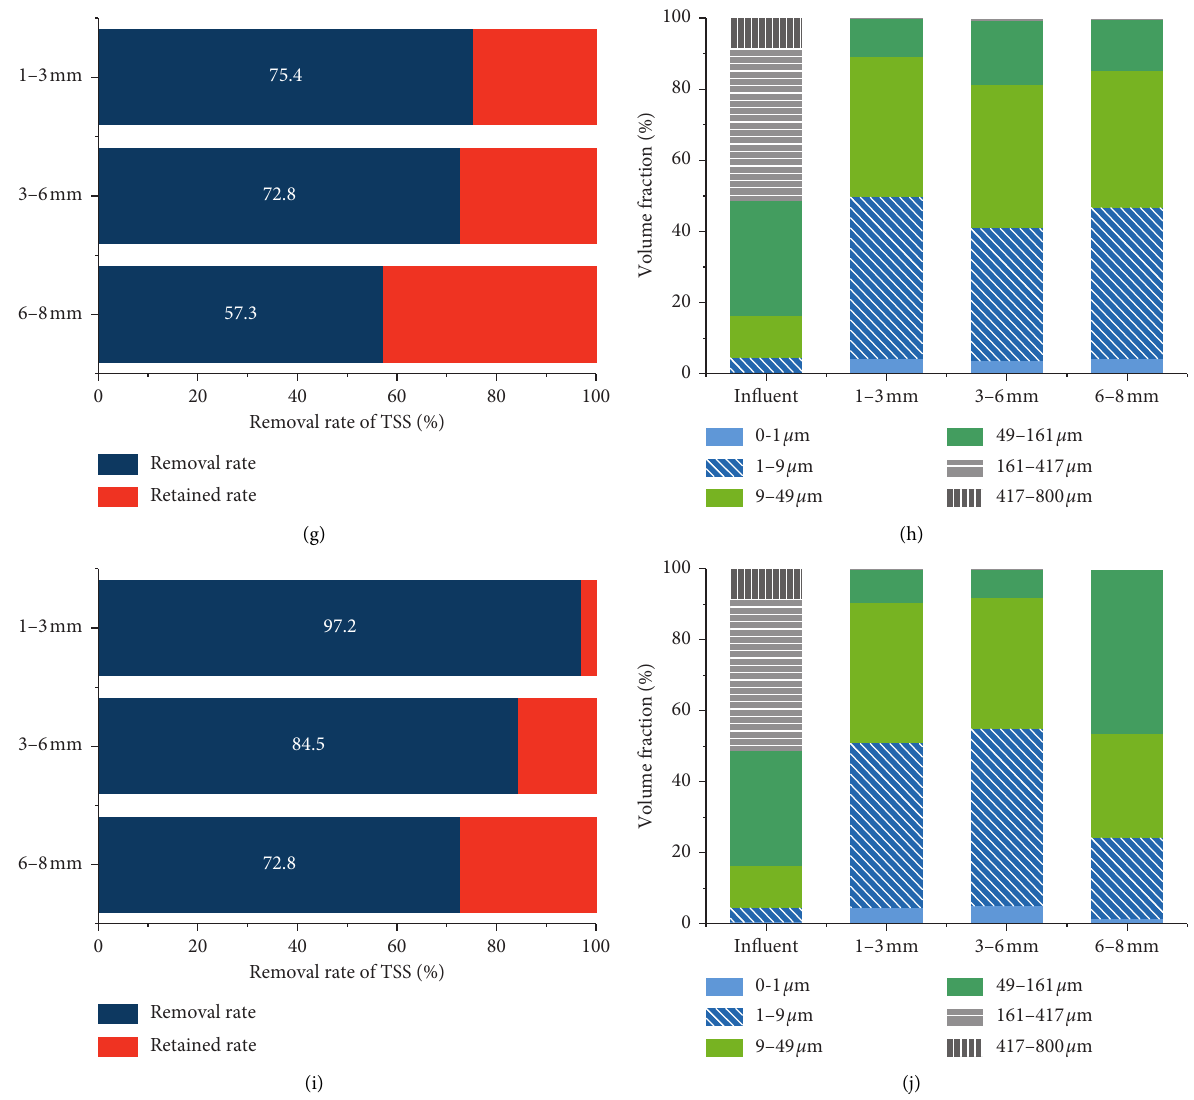
Figure 6: Effect of grain size on particle removal efficiency of different filter media. (a) TSS removal rate (Zeolite). (b) PSD based on subdivided intervals (Zeolite). (c) TSS removal rate (Ceramsite). (d) PSD based on subdivided intervals (Ceramsite). (e) TSS removal rate (Slag). (f) PSD based on subdivided intervals (Slag). (g) TSS removal rate (Diatomite). (h) PSD based on subdivided intervals (Diatomite). (i) TSS removal rate (Vesuvianite). (j) PSD based on subdivided intervals